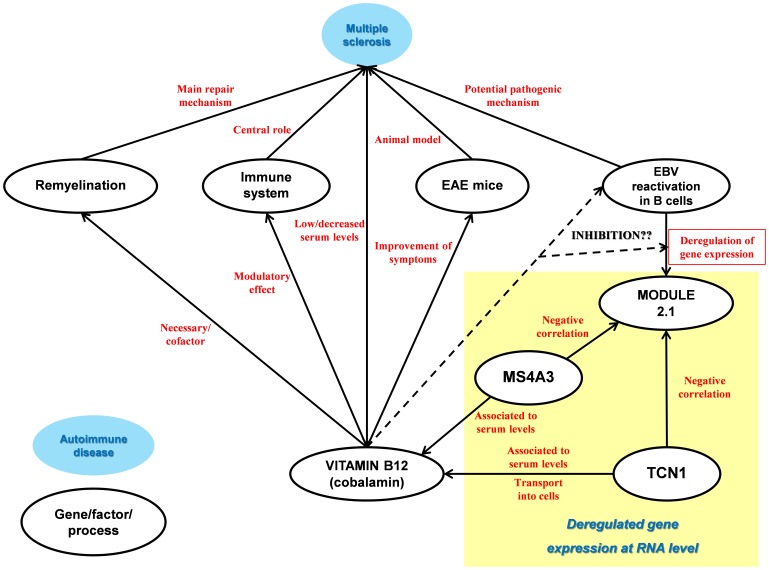
Functional relations between vitamin B12 and MS-related elements as described by literature along with the relevant gene expression regulation relations deduced from the coexpression network.